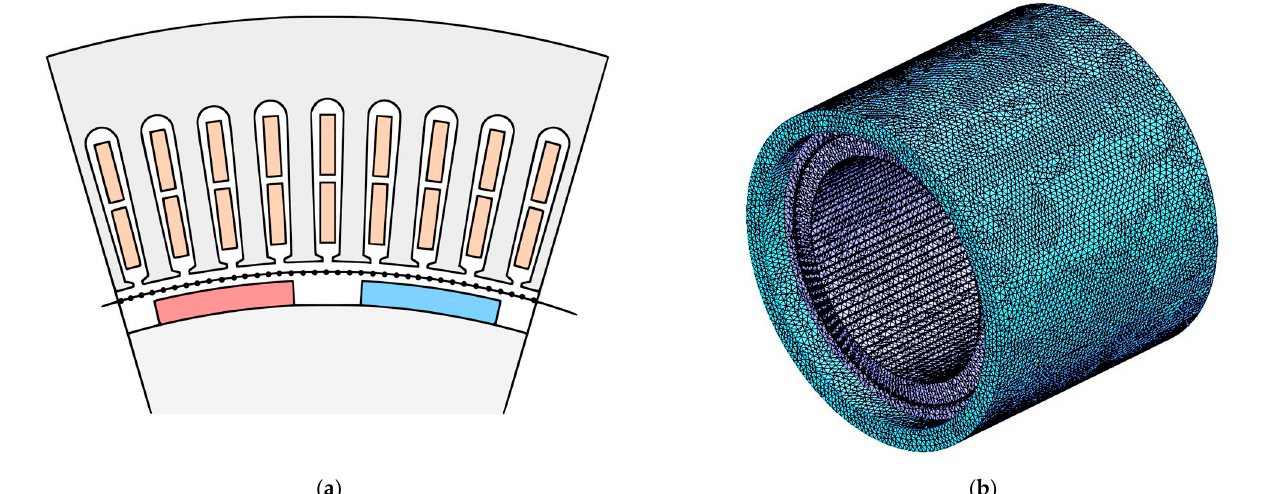
Figure 8. ( a ) Two-dimensional model for calculations of the electromagnetic force and ( b ) three- dimensional model for structural calculations.